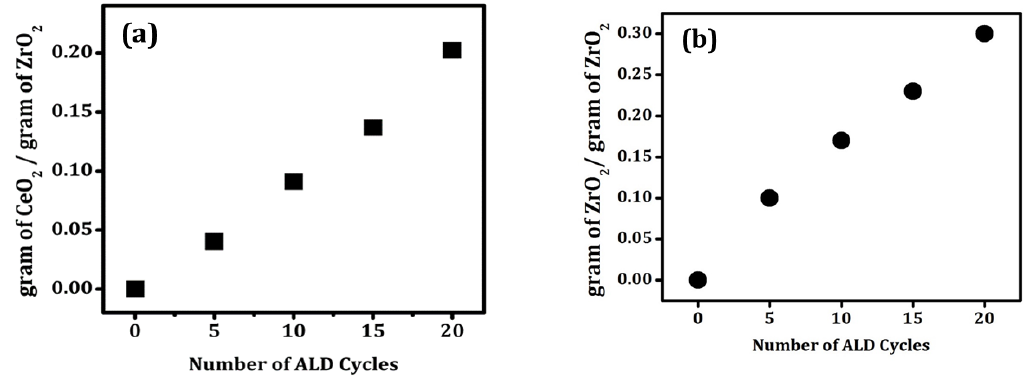
Figure 1. Growth curves for atomic layer deposition (ALD) films on an 84 m 2 /g ZrO 2 powder: ( a ) CeO 2 ALD; ( b ) ZrO 2 ALD. All masses were measured after thermal treatment to ensure the removal of moisture content.